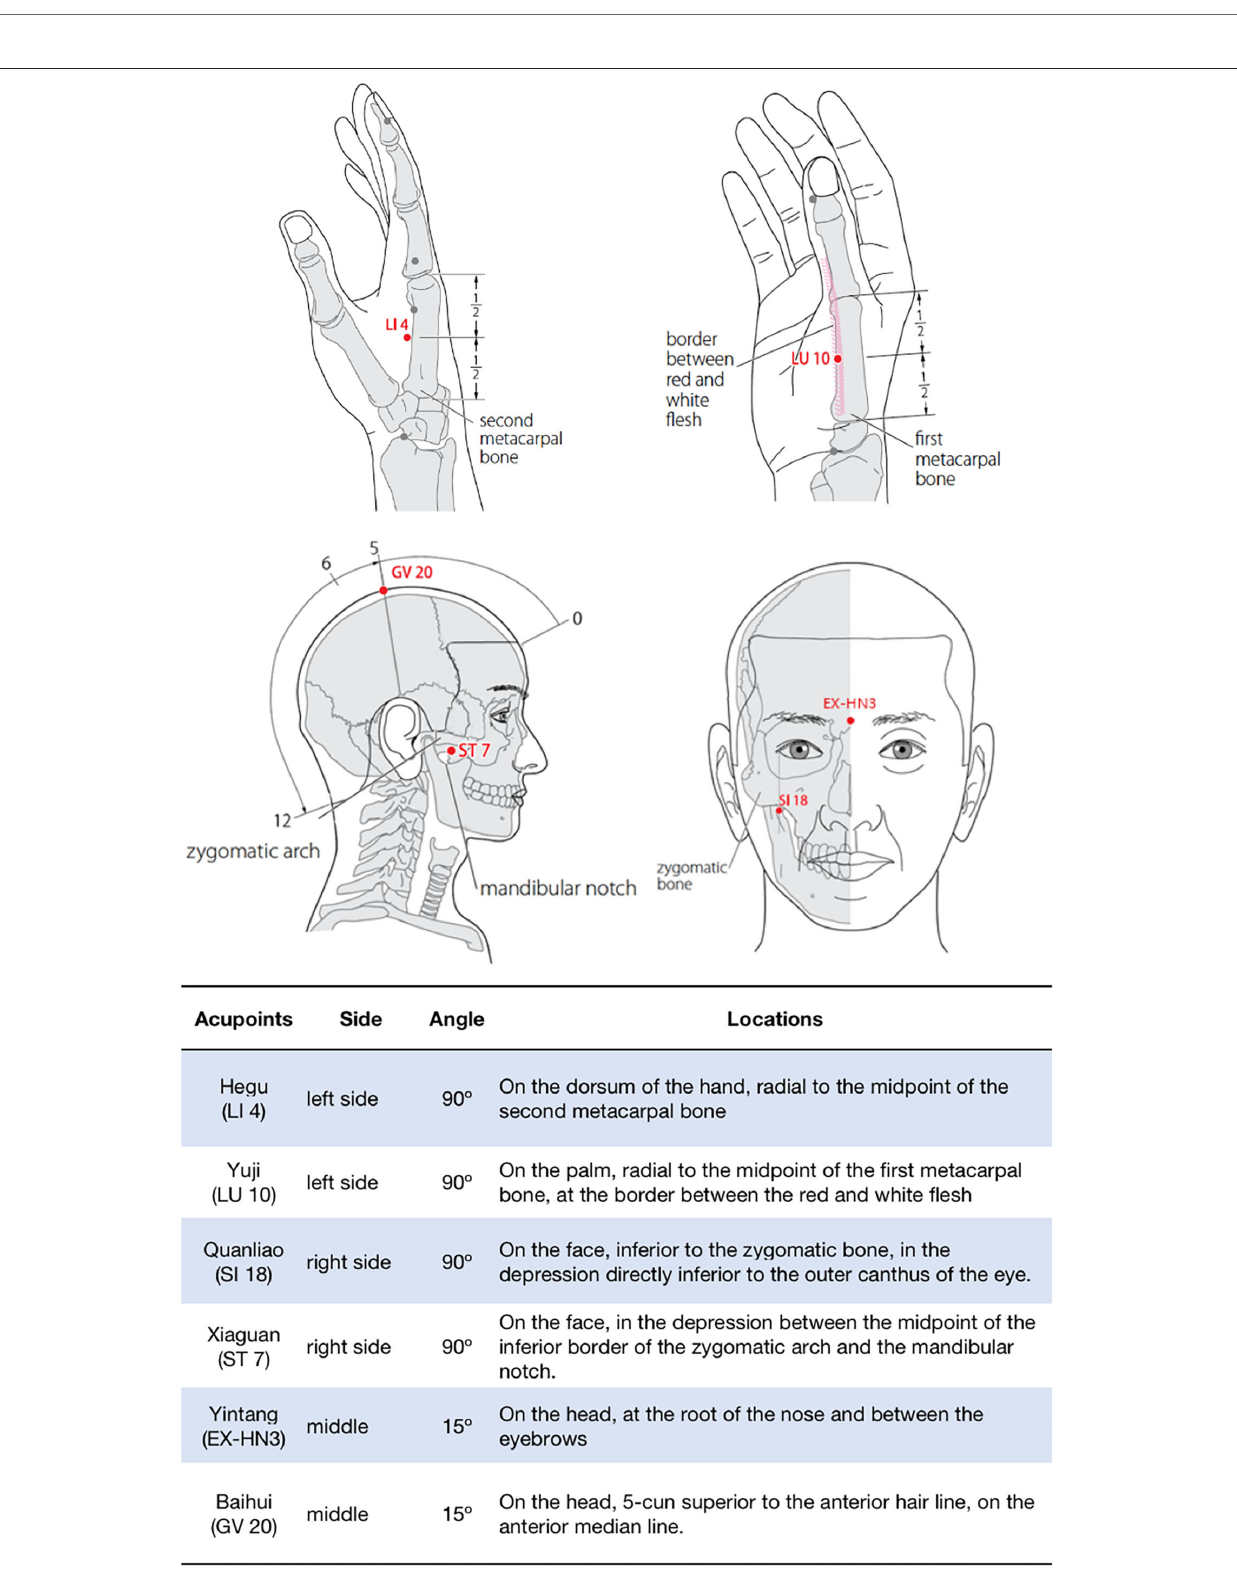
FIGURE 2 | Locations of acupoints. (WHO